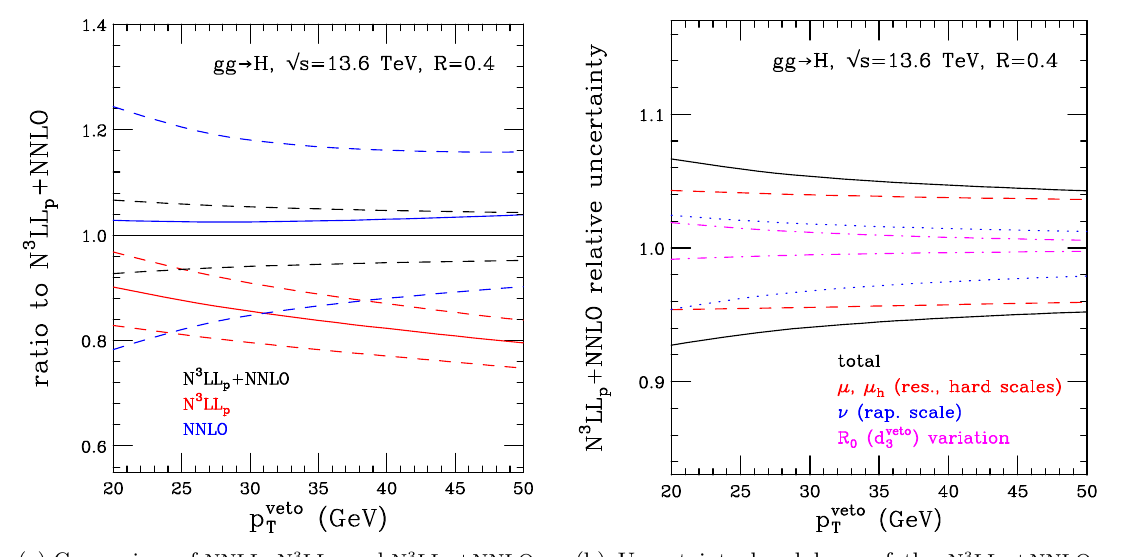
√ s = 13 . 6 TeV as a function of the jet veto. + NNLO prediction, broken down p